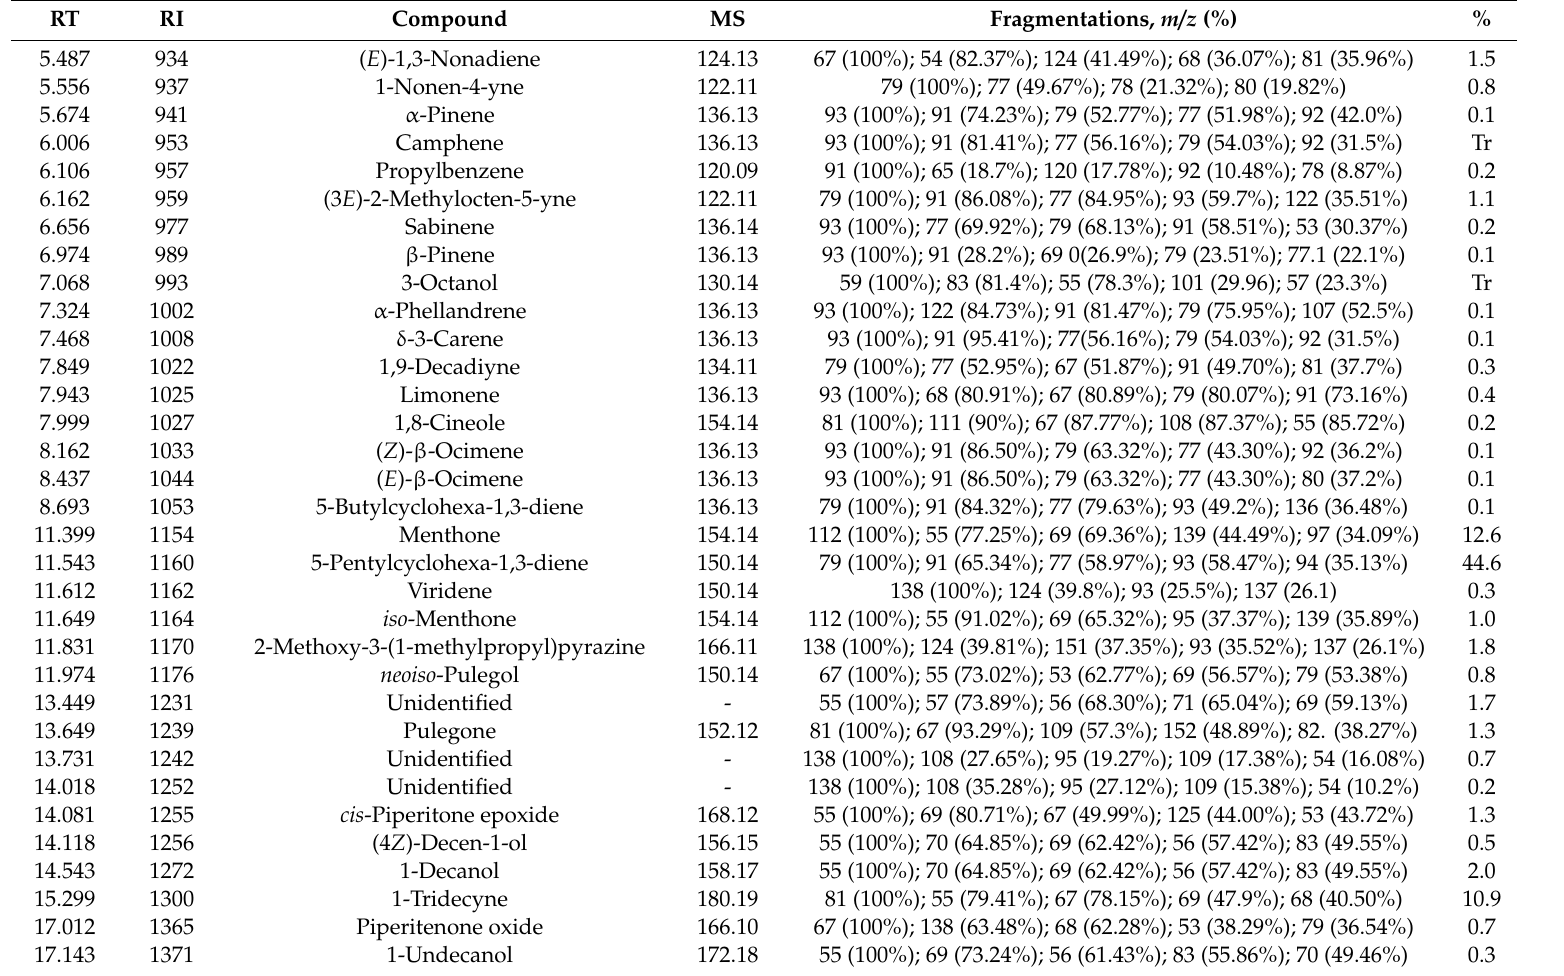
Table 1. Chemical composition of the essential oil of the roots of Prangos pabularia growing wild in